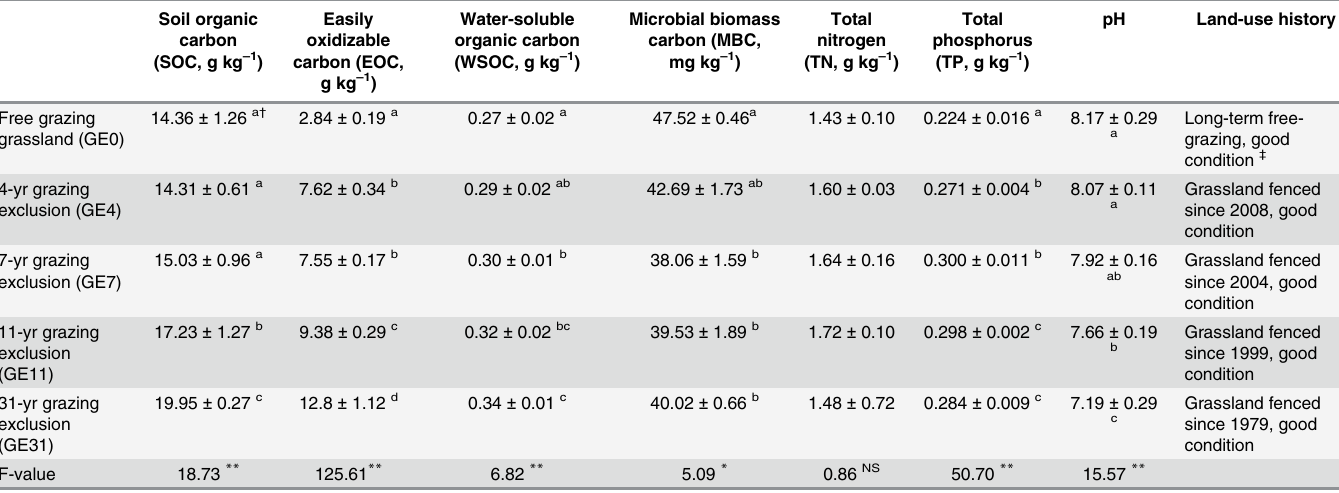
Table 1. Changes in soil properties with grazing-exclusion duration in in the Inner Mongolian grasslands. Soil organic carbon (SOC, g kg – 1